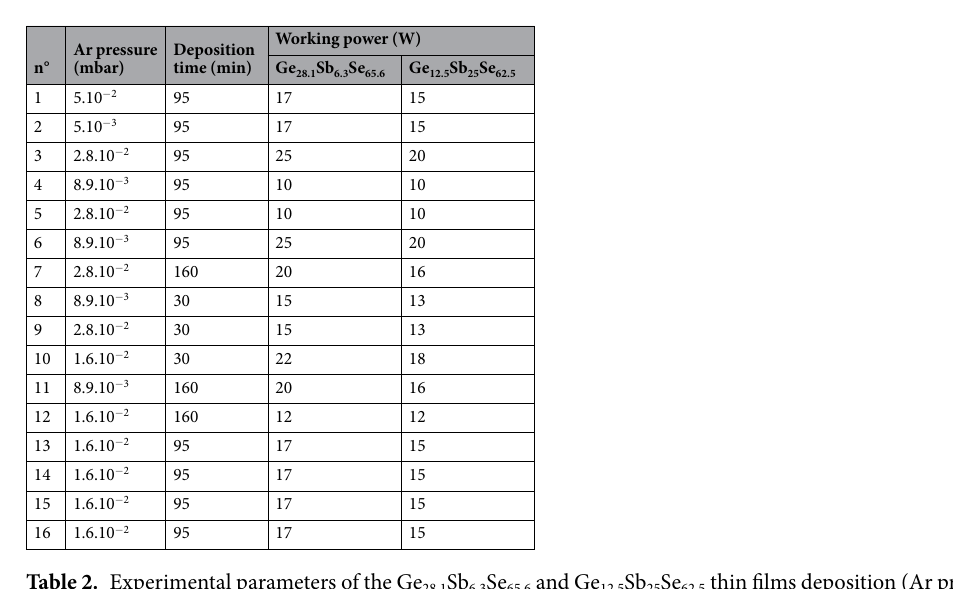
Table 2. Experimental parameters of the Ge 28.1 Sb 6.3 Se 65.6 and Ge 12.5 Sb 25 Se 62.5 thin films deposition (Ar pressure, deposition time, working